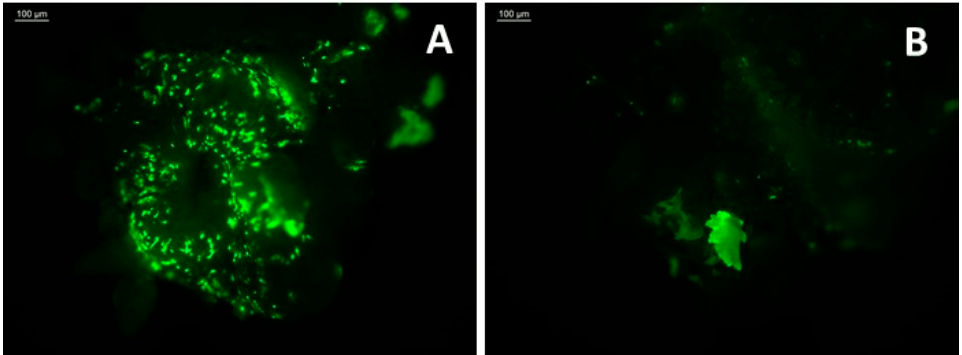
Figure 5. GFP expression of ‘Canino’ hypocotyl slices four weeks after infection with the Agrobacterium tumefaciens strain LB4404 harboring the pMOG-e yfp -IV2 plasmid. ( A ) Transformation events as spots and zones expressing GFP. ( B ) Chimerical bud showing GFP-expressing zones in some leaves. Table 1. Transformation of ‘Canino’ hypocotyl slices by LBA4401 carrying pMOG-e yfp -IV2 based on GFP expression.